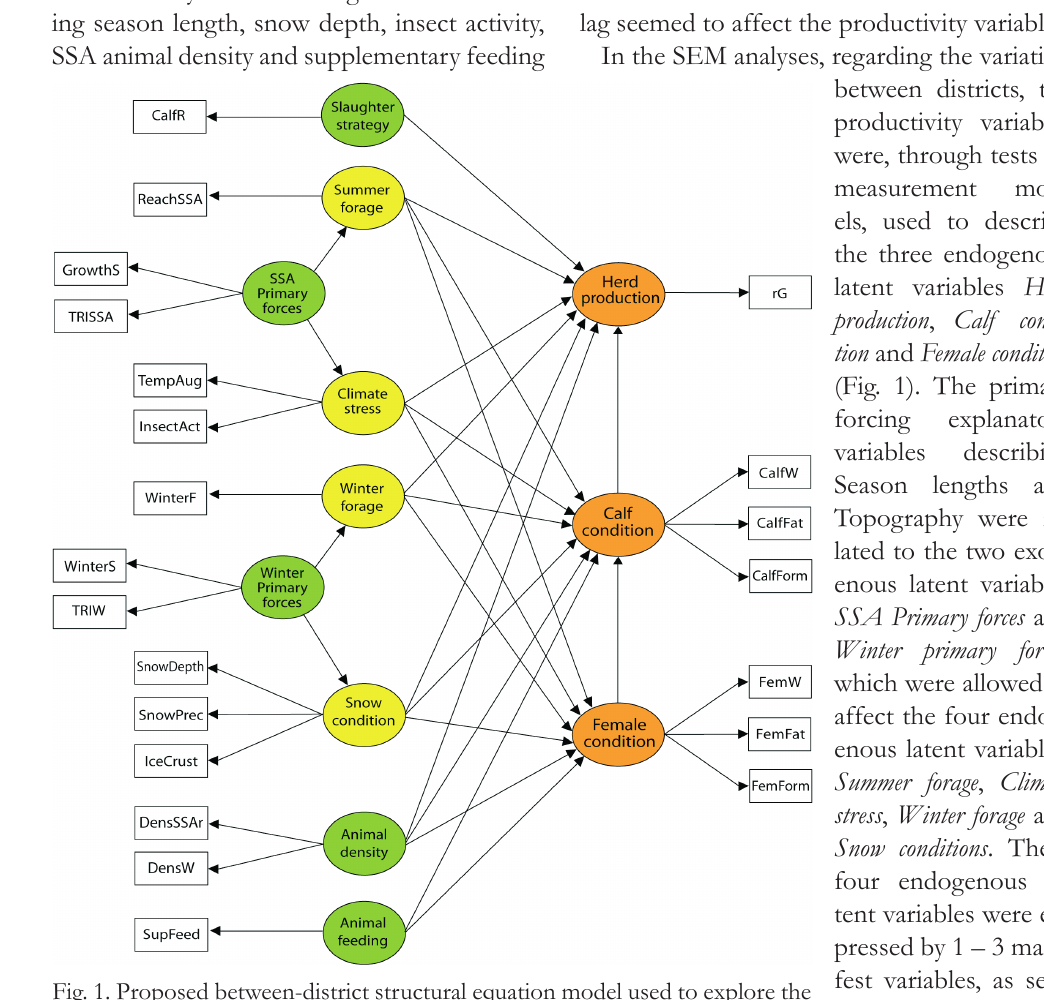
Fig. 1. Proposed between-district structural equation model used to explore the relationship structure between the environmental, constructed latent and pro- ductivity variables. Measured manifest variables are shown in white, exogenous explanatory latent variables in green, endogenous explanatory latent variables in yellow and endogenous productivity latent variables in